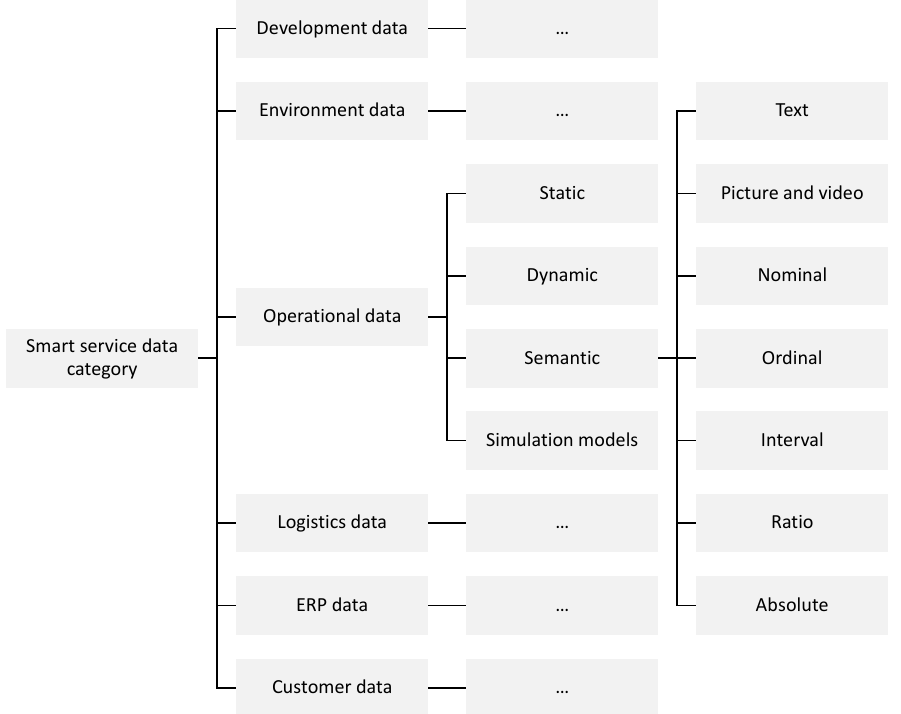
Figure 8. Data categories for the specification of smart service